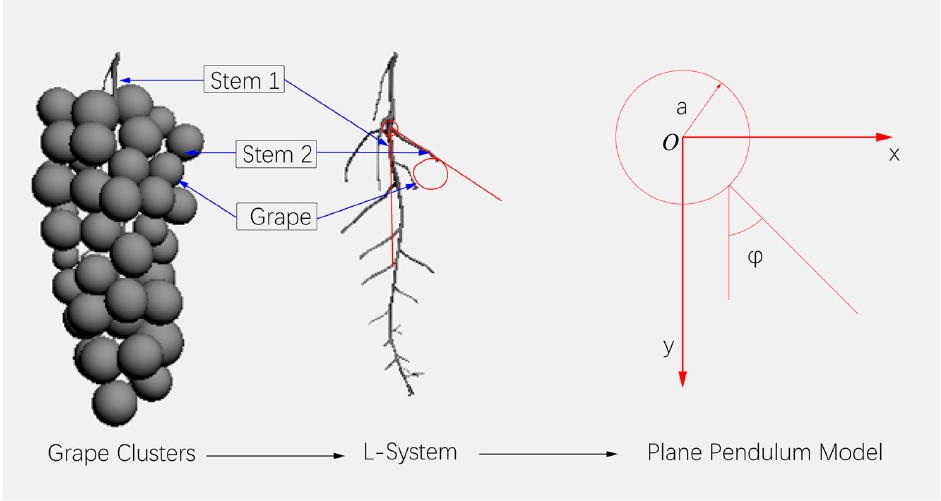
Figure 1. Grape plane pendulum model.